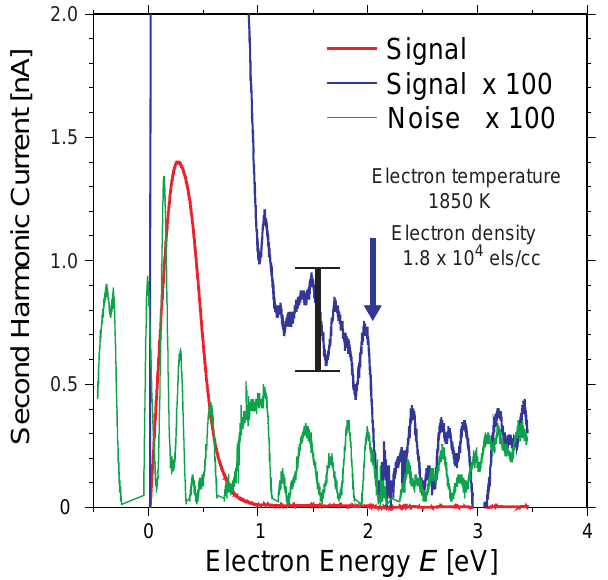
Fig. 3. The second harmonic component. Amplitude of sinusoidal wave superposed to the probe sweep voltage is 200mV. The second harmonic components discriminated by blue line is amplified 100 times higher than the red curve. The green line shows noise when the second harmonic component marked by red line is amplified 100 times. N 2 gas pressure and N e are 1 × 10 − 1 Pa, and 1 . 8 × 10 4 els/cc, respectively. T e that is calculated from thermal energy is 1850K. Please note that the signal drops sharply around 2eV. The black vertical line indicated the magnitude of the noise. A blue arrow indicates the energy where the second harmonic component reduces